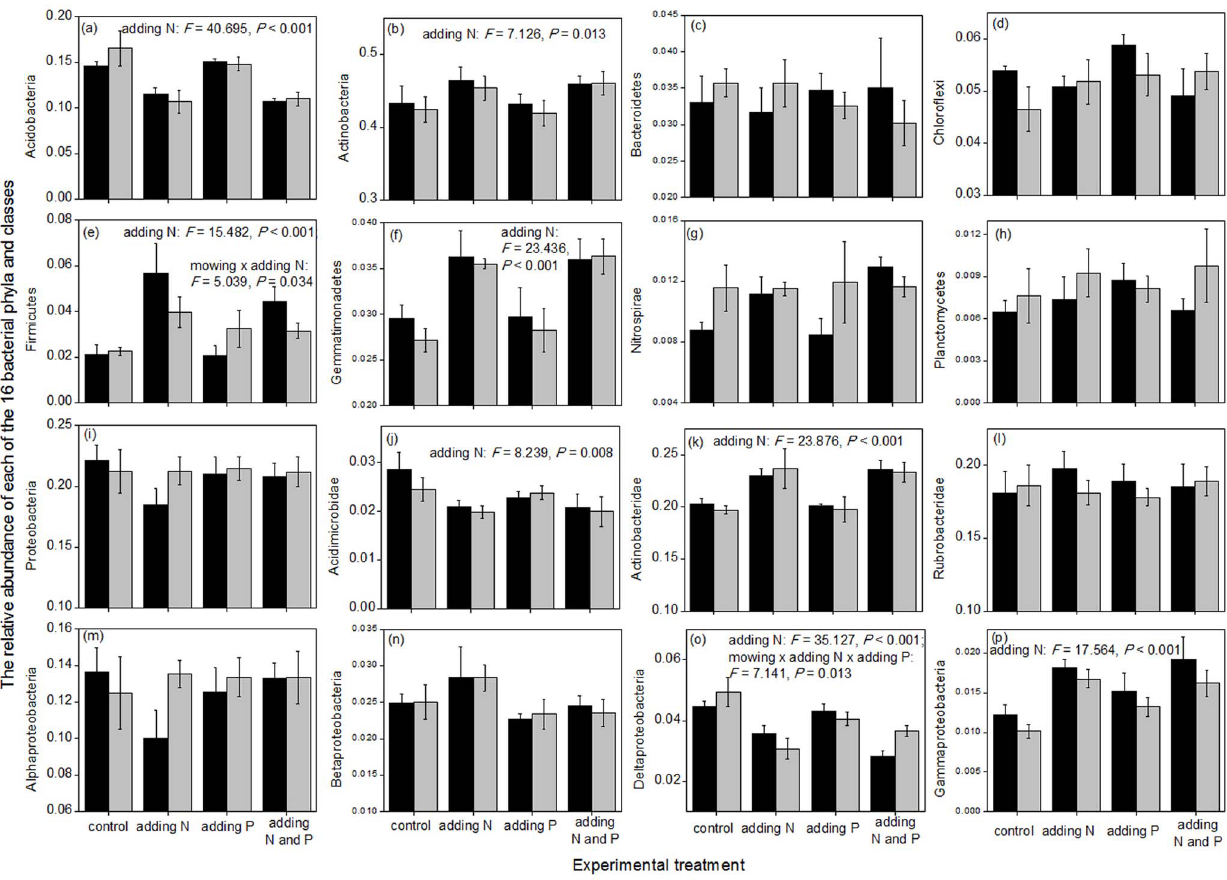
Figure 2. Effects of experimental treatments on the relative abundances of 16 dominant bacterial phyla/classes. Three-way ANOVA was used to test the effect of experimental treatments. For clarity, only the significant statistical results ( P , 0.05) are shown in the figure. The bars represent one standard error (n=4). The black and gray columns represent the treatments without and with mowing, respectively.